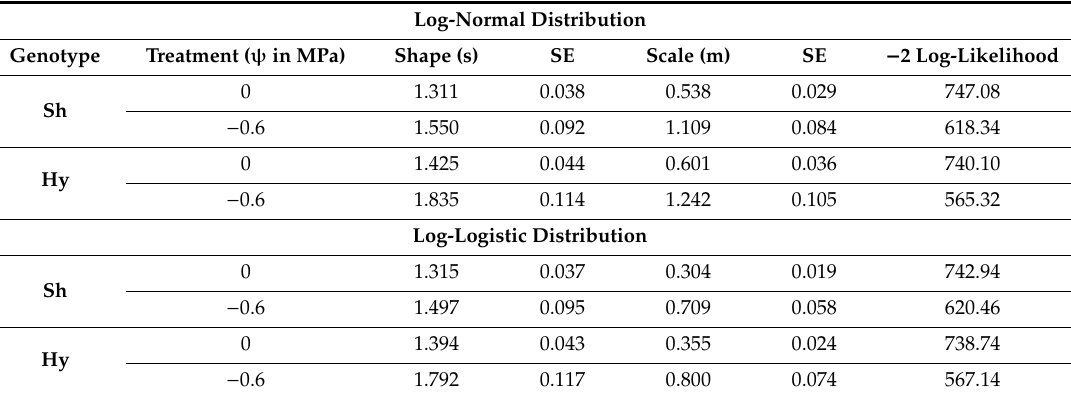
Table 3. Shape (s) and scale (m) parameters of the log-normal and log-logistic distributions as estimated by the Maximum Likelihood Estimates (MLE). SE represents the standard error.